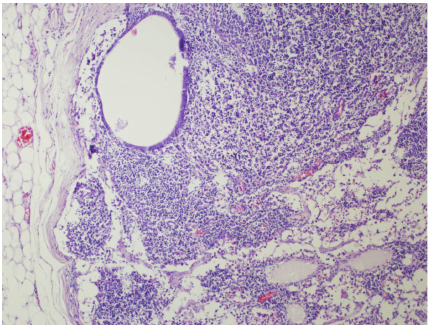
Figure 1: Image of the involved small bowel segment with endometriosis. (a) The proximal-dilated part of the terminal ileum. (b) The stricture caused by endometriosis. (c) The collapsed distal part of the terminal ileum. (d) Involved regional lymph nodes with endometriosis.